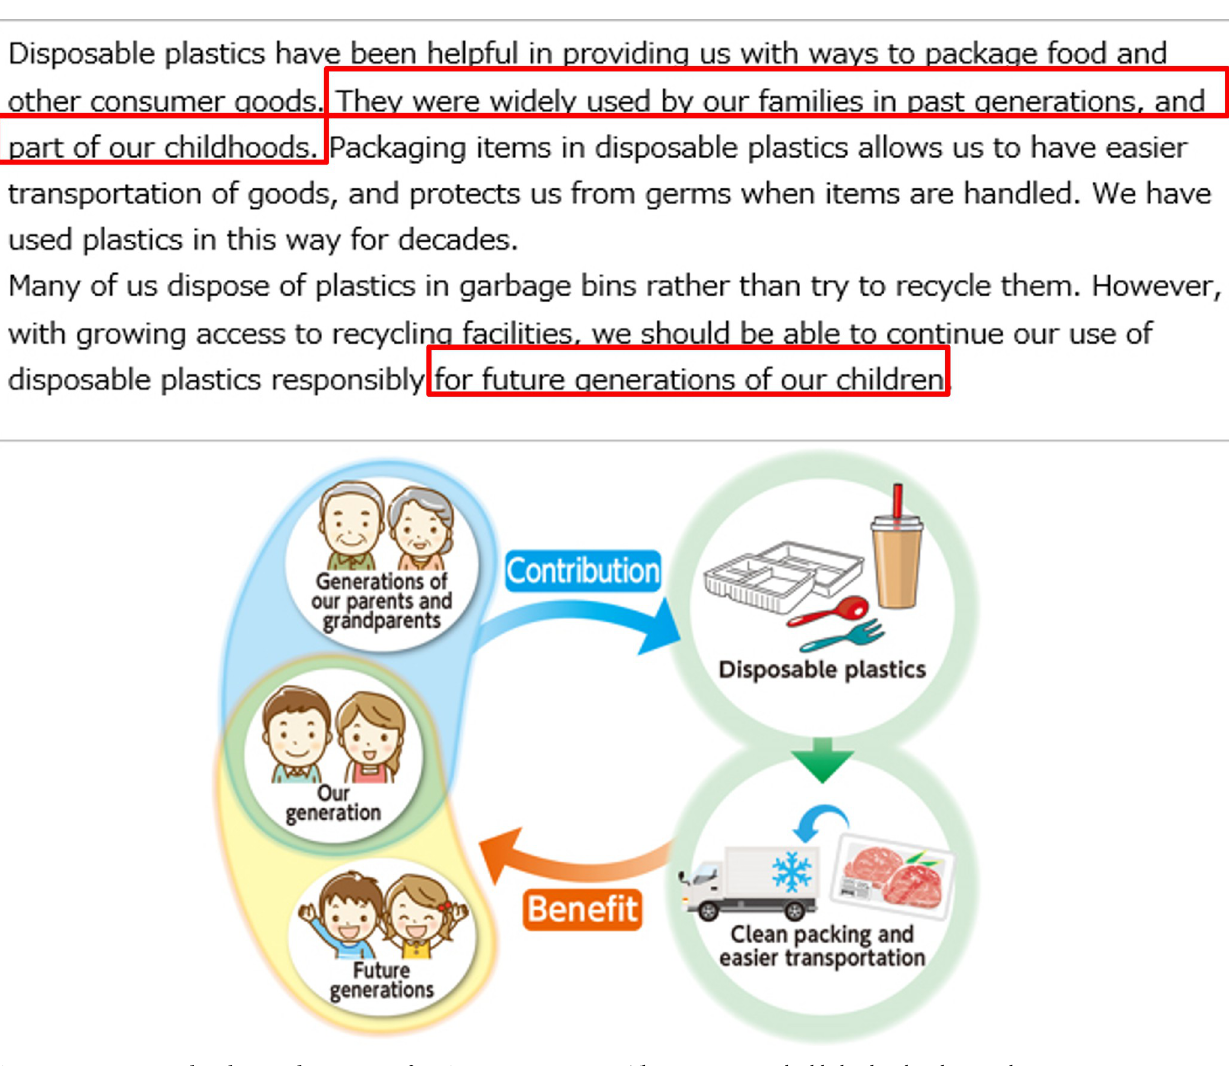
Fig 5. Message presented to those under 50 years of age in treatment group 2. The intervention is highlighted with red